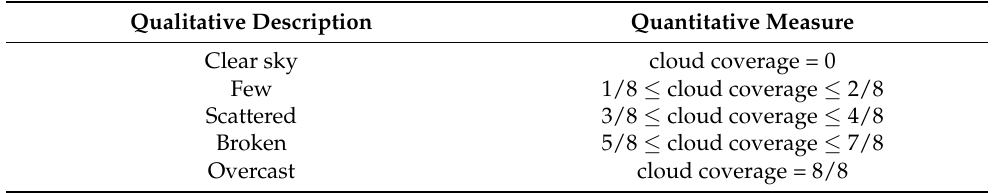
Table 1. FAA quantitative definitions of cloud coverage. Figure 1. AIC Identification Scope Block Diagram.